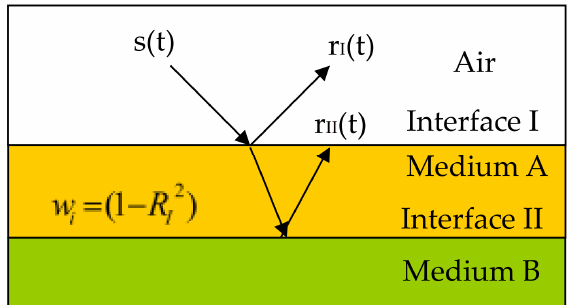
Figure 5. Electromagnetic Wave Reflection Behavior in Double-layered Medium.